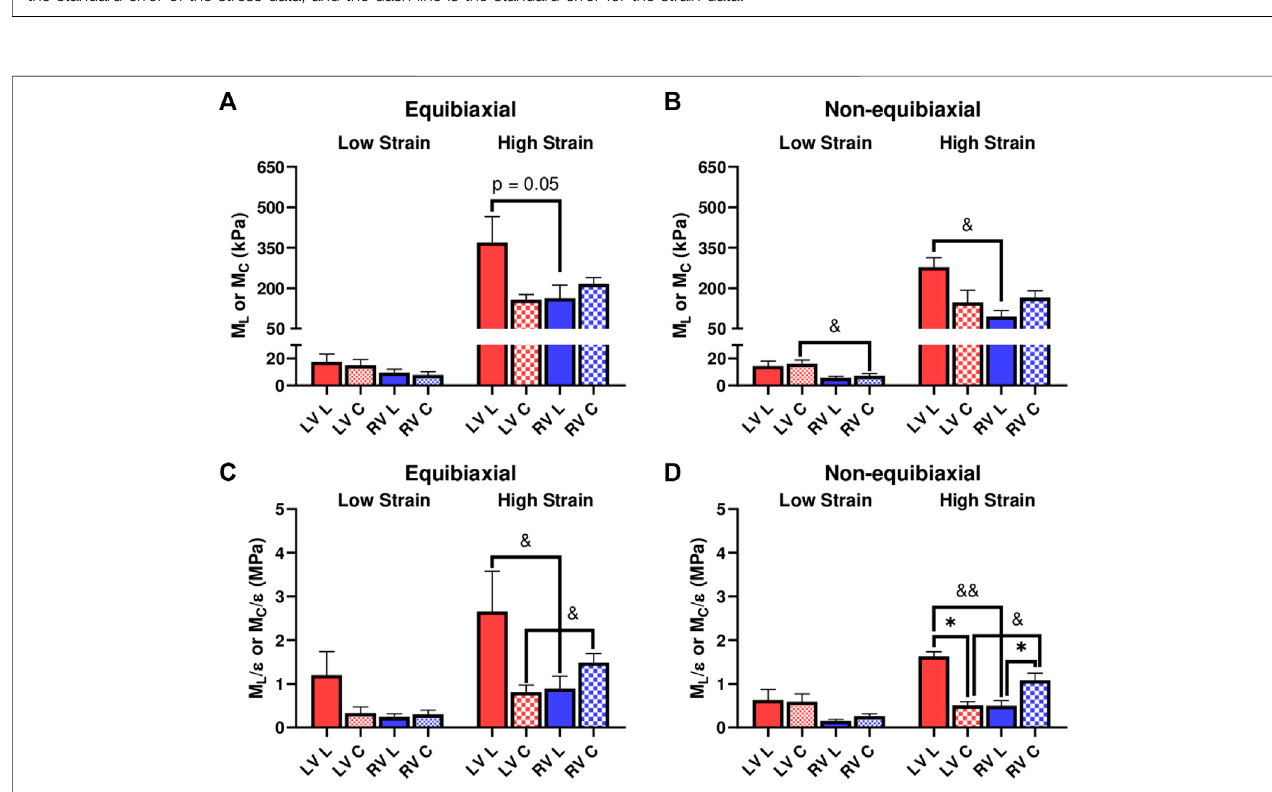
FIGURE3|(A,B) Elasticmoduli( M )ofLVsandRVsfromtheequibiaxial (A) andnon-equibiaxialtests (B) . (C,D) Strain-weightedelasticmoduli( M / ε )ofLVsandRVs from the equibiaxial (C) and non-equibiaxial tests (D) . For the equibiaxial tests, n = 7 per group; for the non-equibiaxial tests, LV, L: n = 4; LV, (C) n = 5; RV, L: n = 7; RV, (C) n = 6. *: p < 0.05 comparison between the directions and p < 0.05 and p < 0.01 for comparison between the